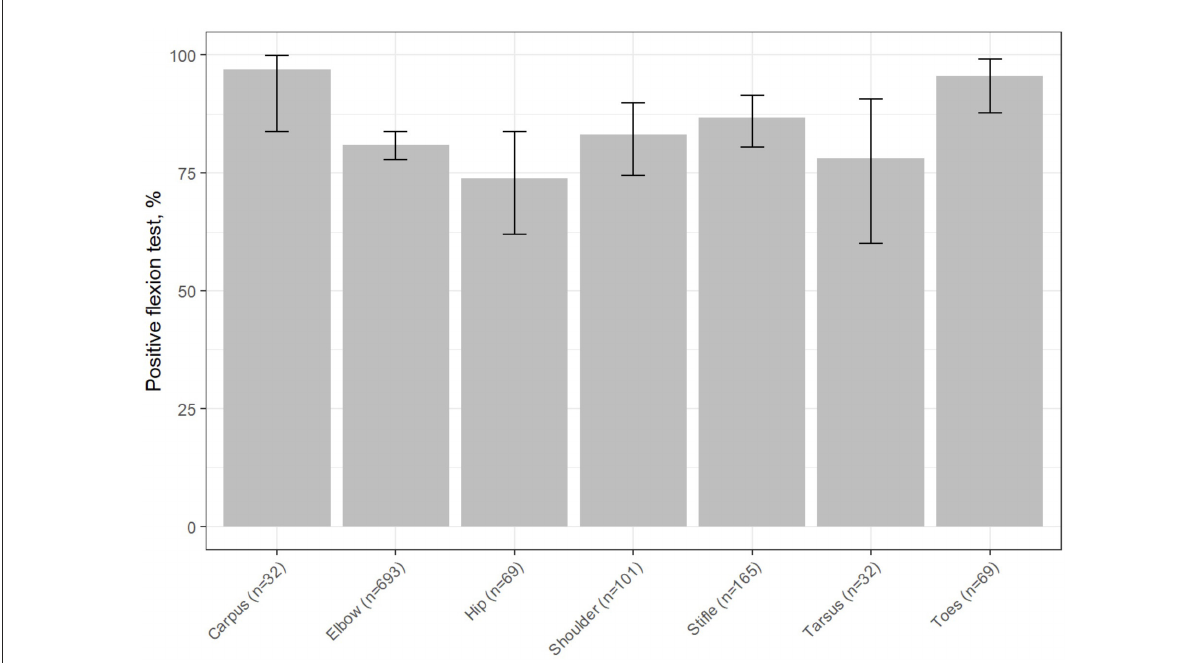
FIGURE2 Percentage of positive FT results considered by joint area [ x , joint area (and an indication of the number of positive results); y , percentage of positive FTs]. The T bar indicates the 95%IC.